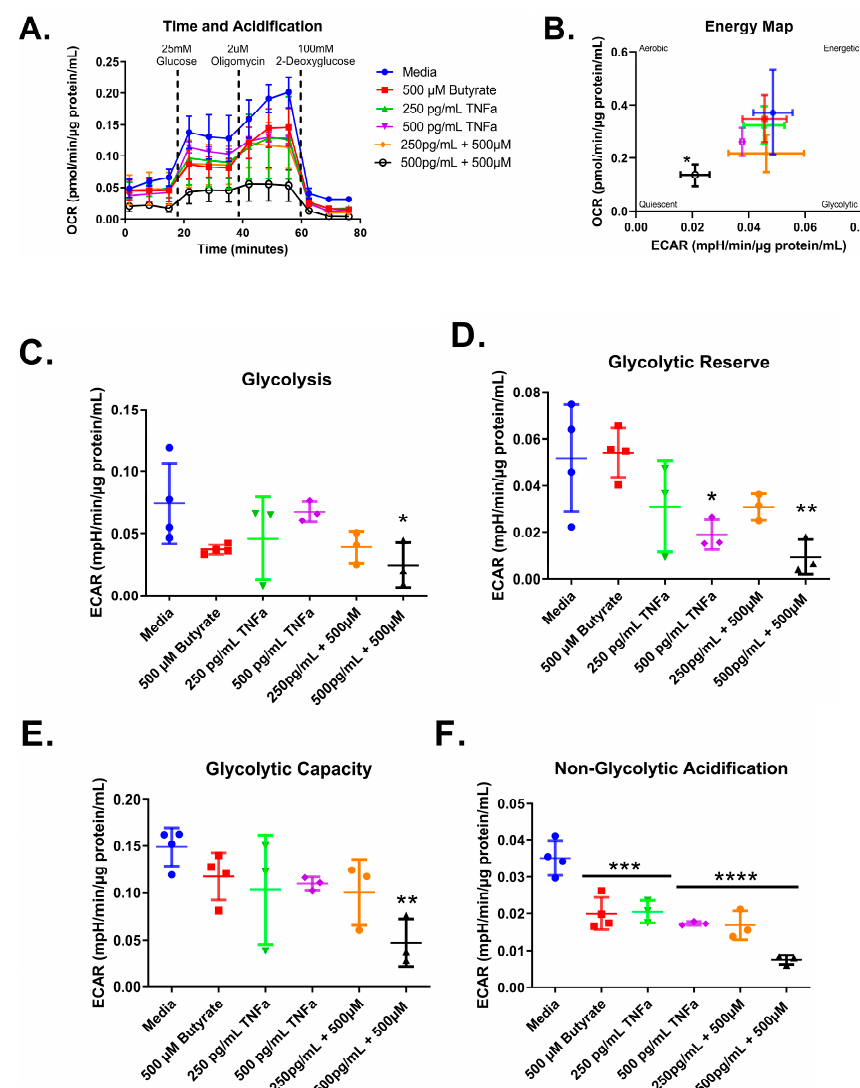
Figure 9. Normalized extracellular acidification rate for primary rat colon epithelial cells after 24 h exposure to butyrate and TNF α . ( A ) Acidification rates over time, ( B ) energy map, ( C ) glycolysis, ( D ) glycolytic capacity, ( E ) glycolytic reserve, and ( F ) non-glycolytic acidification. Data are presented as mean ± standard deviation. Asterisks indicate degree of significance from medium control (One-way ANOVA followed by a Dunnett’s multiple comparison test, n = 3 or 4; significance determined at * = p < 0.05, ** = p < 0.01, *** = p < 0.001, ****= p < 0.0001).